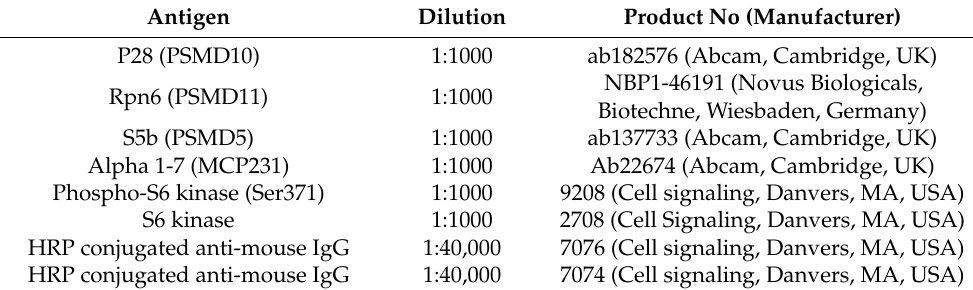
Table 1. Antibodies used in this